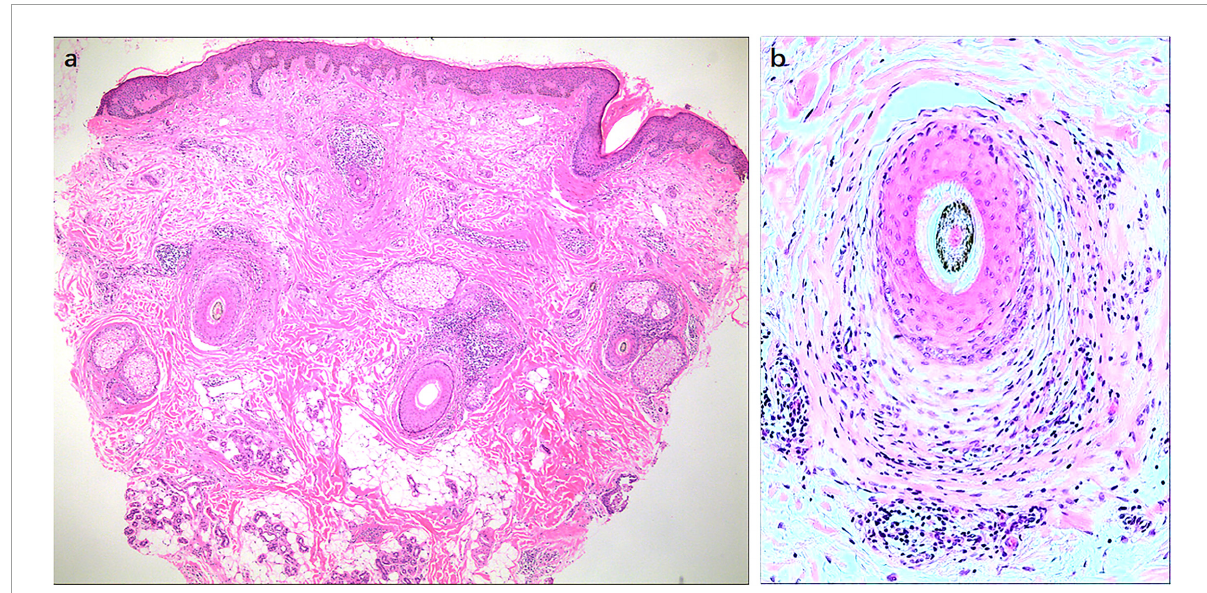
FIGURE2 Histological findings of frontal fibrosing alopecia (FFA). Histological findings in FFA show the inflammatory cell infiltration around lesional LPP HFs, especially near the bulge area and infundibulum. Original magnification: (a) 40X, (b)